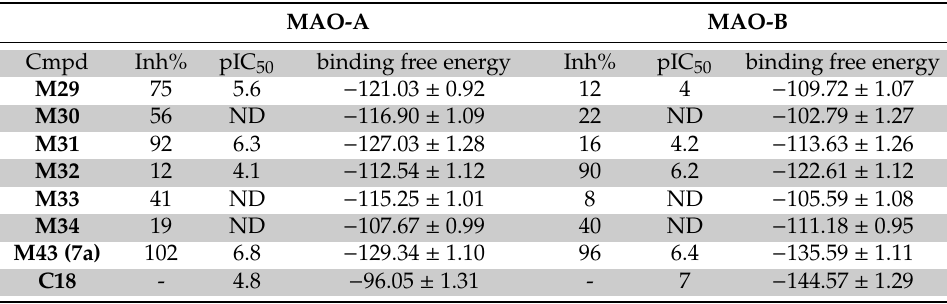
Table 1. Experimental activities and MM / PBSA binding free energies.